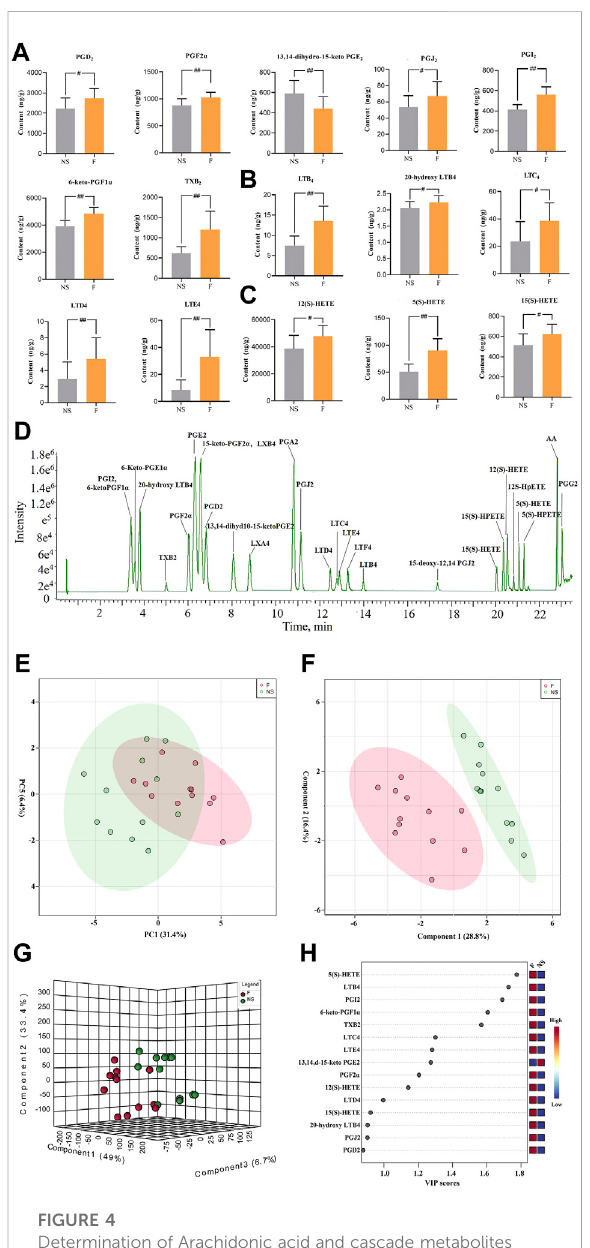
FIGURE 4 Determination of Arachidonic acid and cascade metabolites (AAMs) in lung. (A – C) Alterations in lung of the prostaglandins (A) , leukotrienes (B) and the HETEs (C) metabolites (VIP value > 0.8) after treated mice with penilloic acid (12 mg/kg) ( n = 10). (D) LC-MS/MSchromatogramof28eicosanoidsperformedonatriple quadrupole employing dynamic MRM in negative mode. (E) PCA score plot for comprehensive metabonomics data for lung samples. (F,G) PLS-DA models of metabonomics data for lung samples. (H) The VIP score for major metabolites in